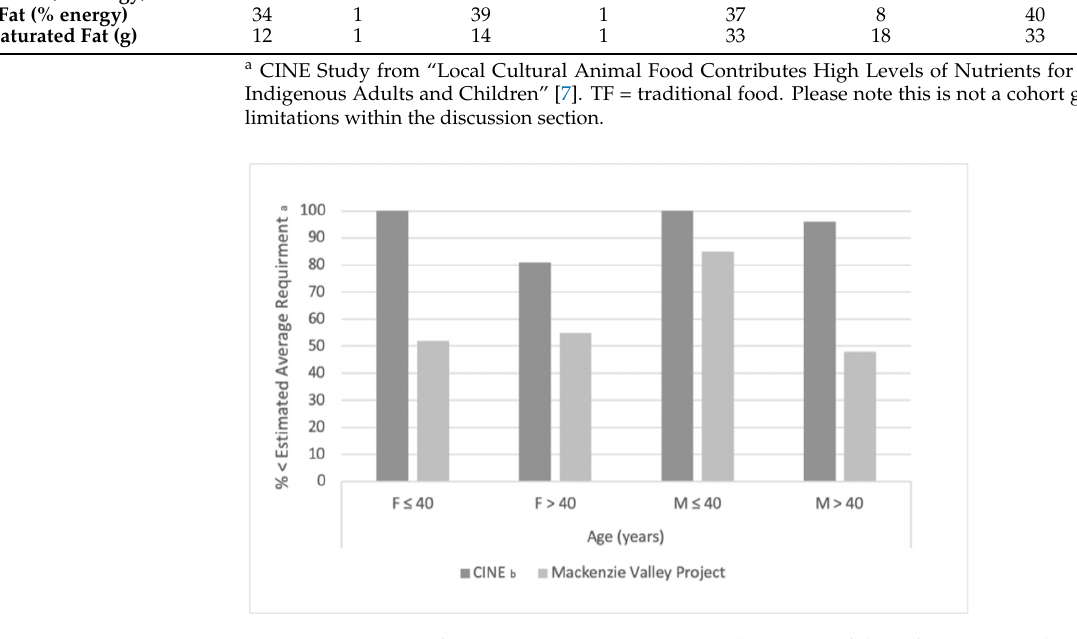
Figure 2. Temporal Comparison Between 1994 (CINE Study) and 2016–2018 (Mackenzie Valley Pro- ject) for Vitamin A Intake less than the Estimated Average Requirement (EAR) in Dene/Métis Adults from the NWT. a For Vitamin A, the EAR was assumed at 500 mg/day for females (F) and 625 mg/day for males (M). b From “Vitamins A, D, and E in Canadian Arctic traditional food and adult diets.’’ [54]. F = female; M = male